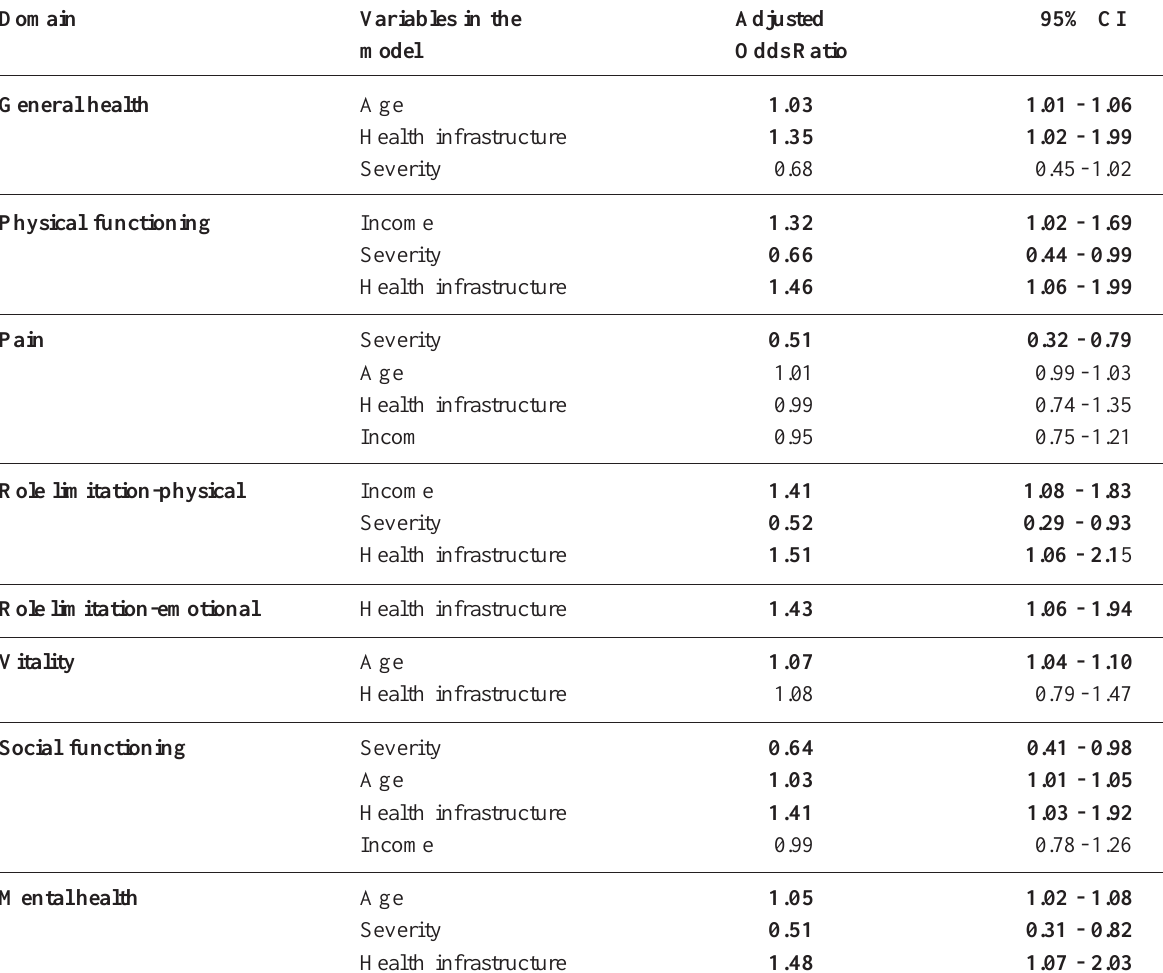
Table 4. Independent predictors of the post-hospital discharge QOL of COPD